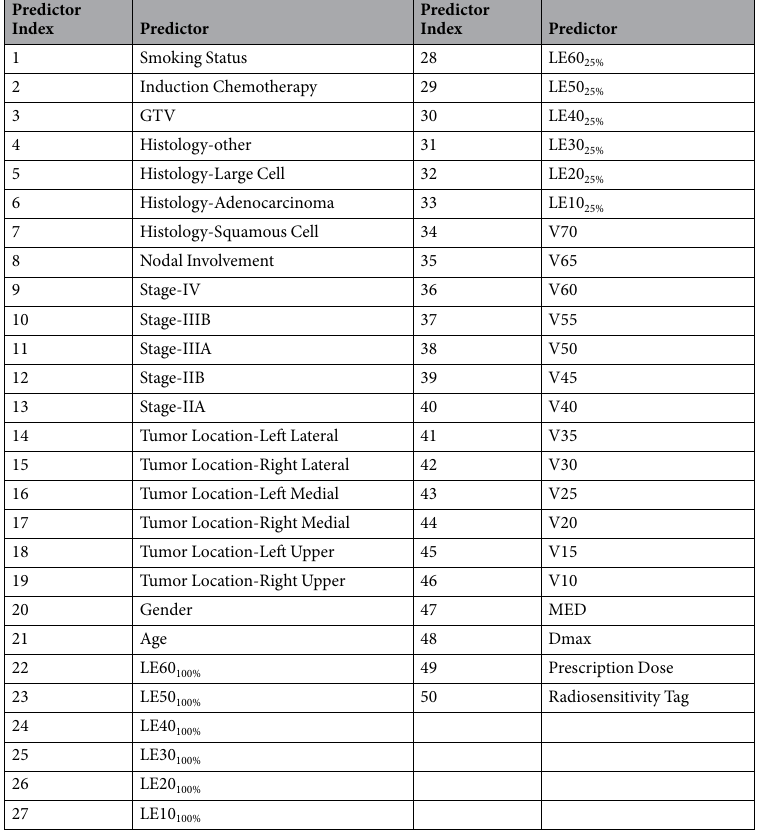
Table 2. Predictor variables used in the NTCP model construction process. Abbreviations : MED = mean esophagus dose; Dmax = maximum esophagus dose; V10 = volume of esophagus receiving at least 10 Gy; LE10 25% = esophageal length with at least 10 Gy to at least 25% of the cross-sectional area to axial slice of the esophagus; LE10 100% = esophageal length with at least 10 Gy to at least 100% of the cross-sectional area to axial slice of the